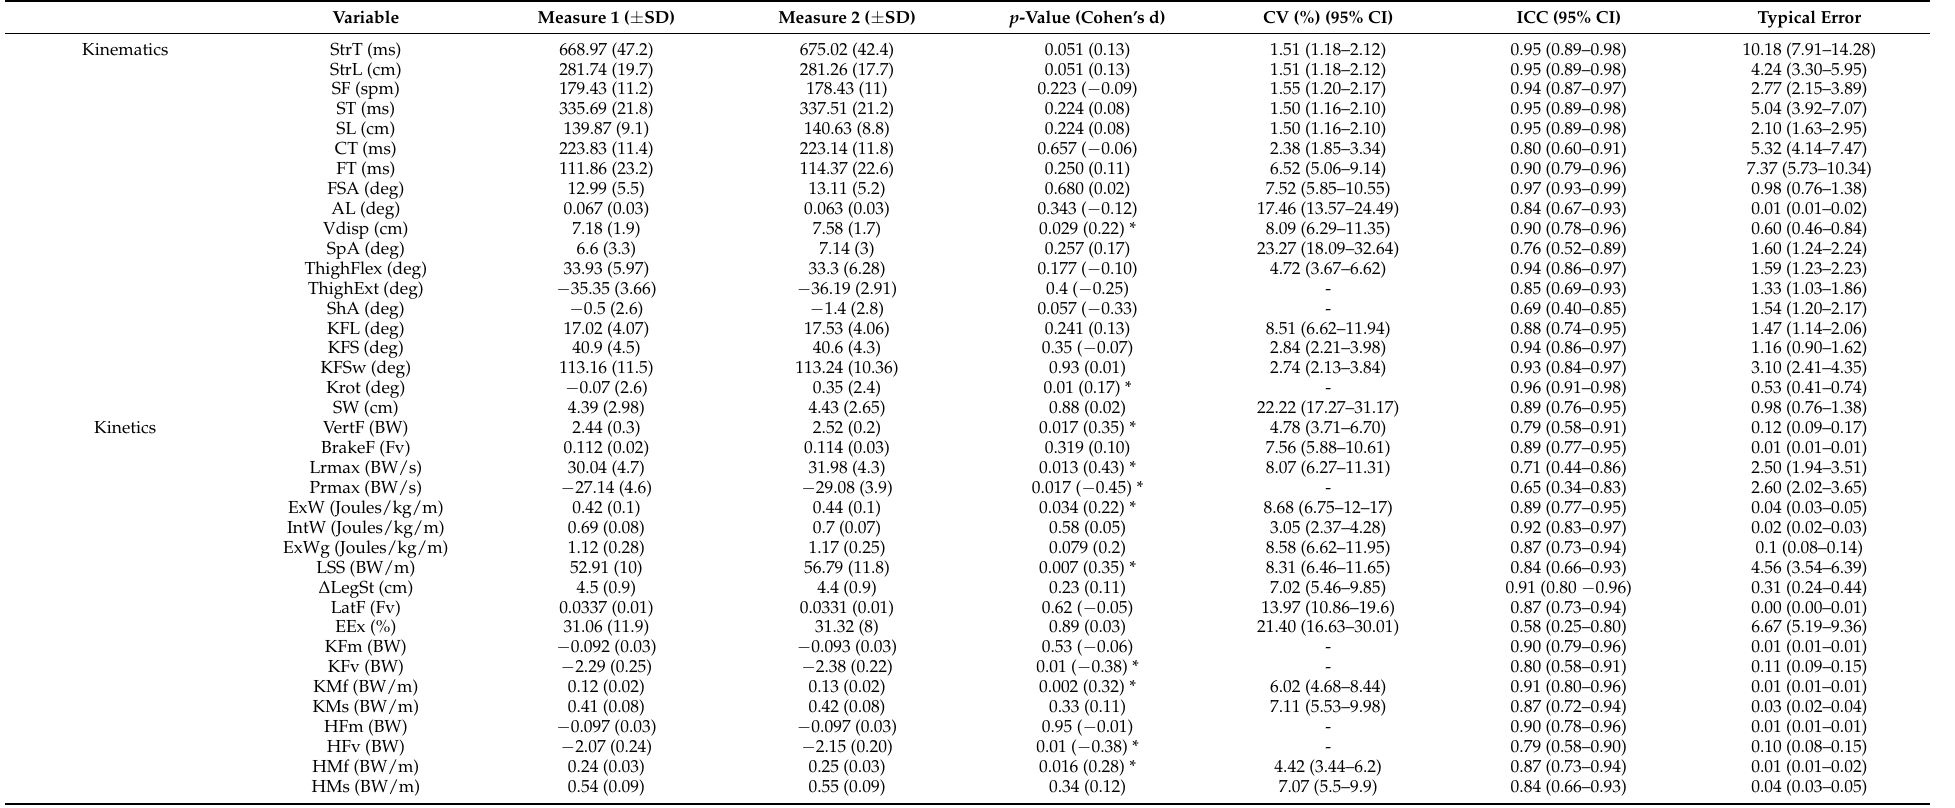
Table 4. Descriptive data (means, ± SD) and inter-session reliability of the kinematic and kinetic parameters obtained from Kinect + MotionMetrix software running at 15 km · h − 1